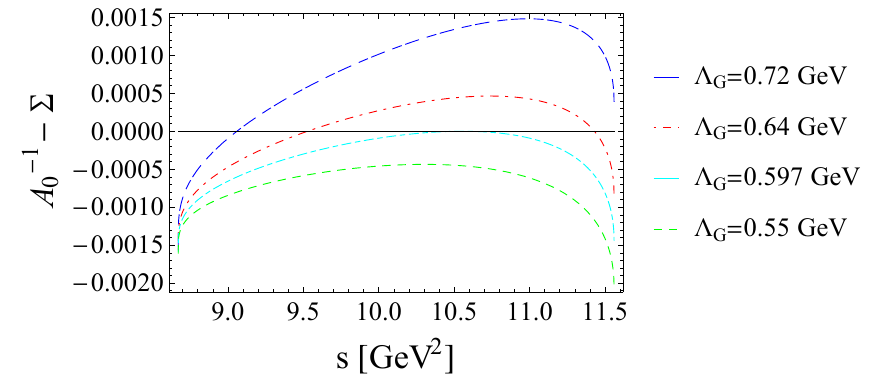
− Σ as function of the energy for ) − 1 = A − 1 0 0